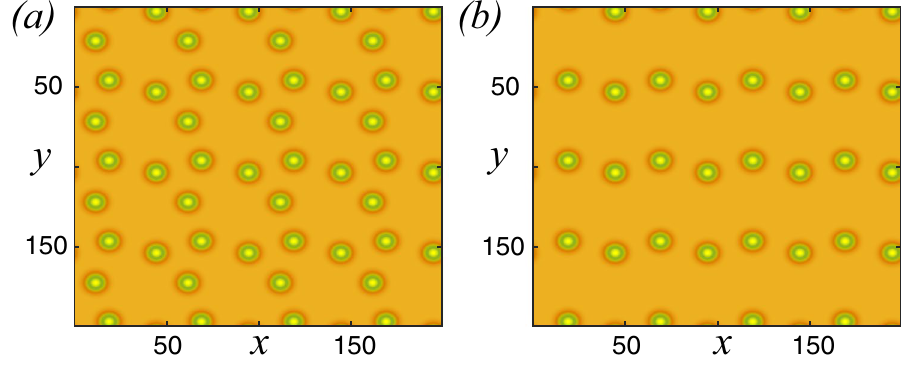
Figure 5. Stationary Localised patches lattice of the interaction-redistribution model Eq. (3). Parameters are κ = 0.6, c D = 0.02, Γ = 0.5, and α =